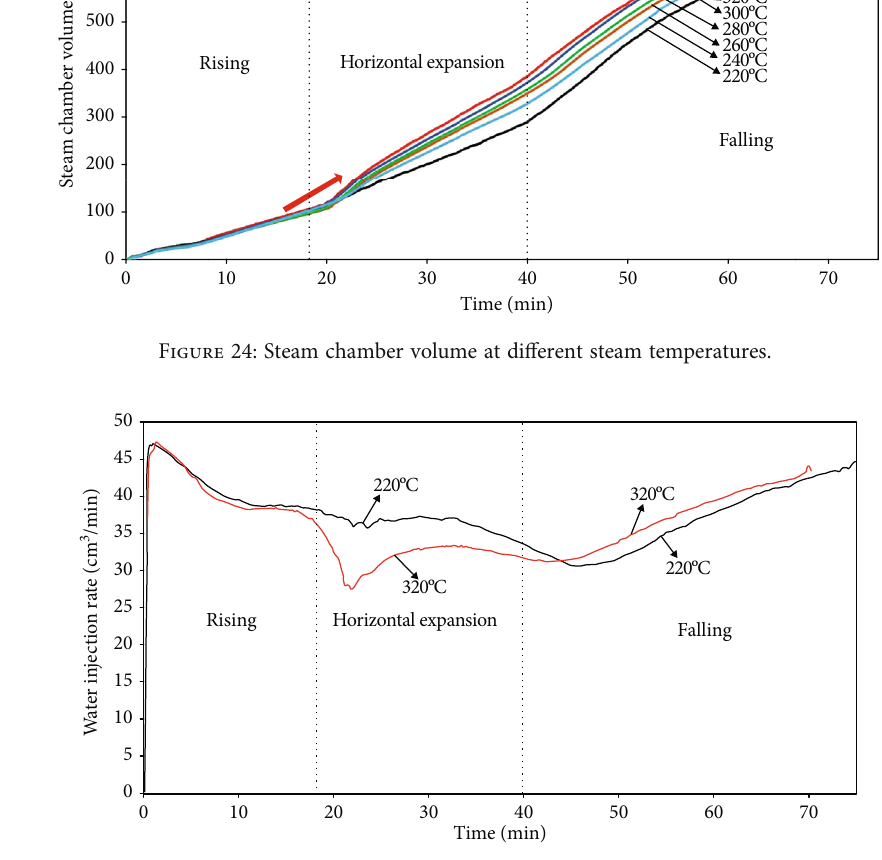
Figure 25: Steam injection rate at di ff erent steam temperatures. Table 6: Steam injection strategy